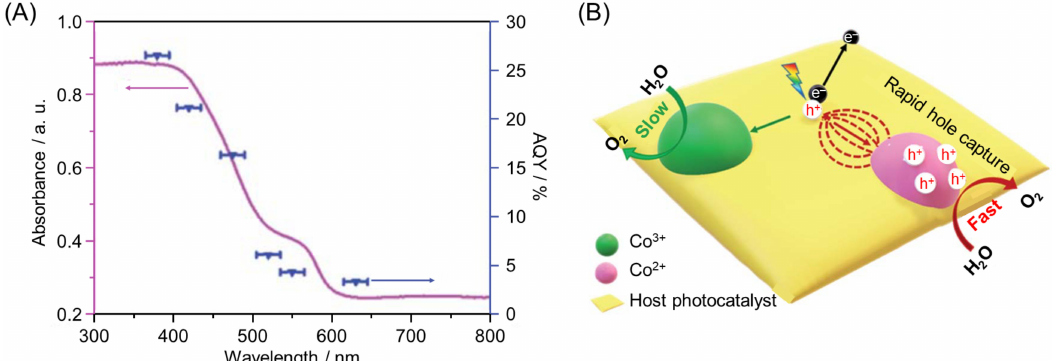
Figure 32. ( A ) Absorption spectrum and wavelength-dependent AQY of photocatalytic O 2 evolution for CoO x (Co 2+ ) NPs/TaON. ( B ) Proposed mechanism of the photocatalytic water-oxidation process of CoO x NPs/TaON, indicating accelerated hole transportation and reaction on the Co 2+ species. Reproduced with permission from reference [243]. Copyright 2021 The Royal Society of